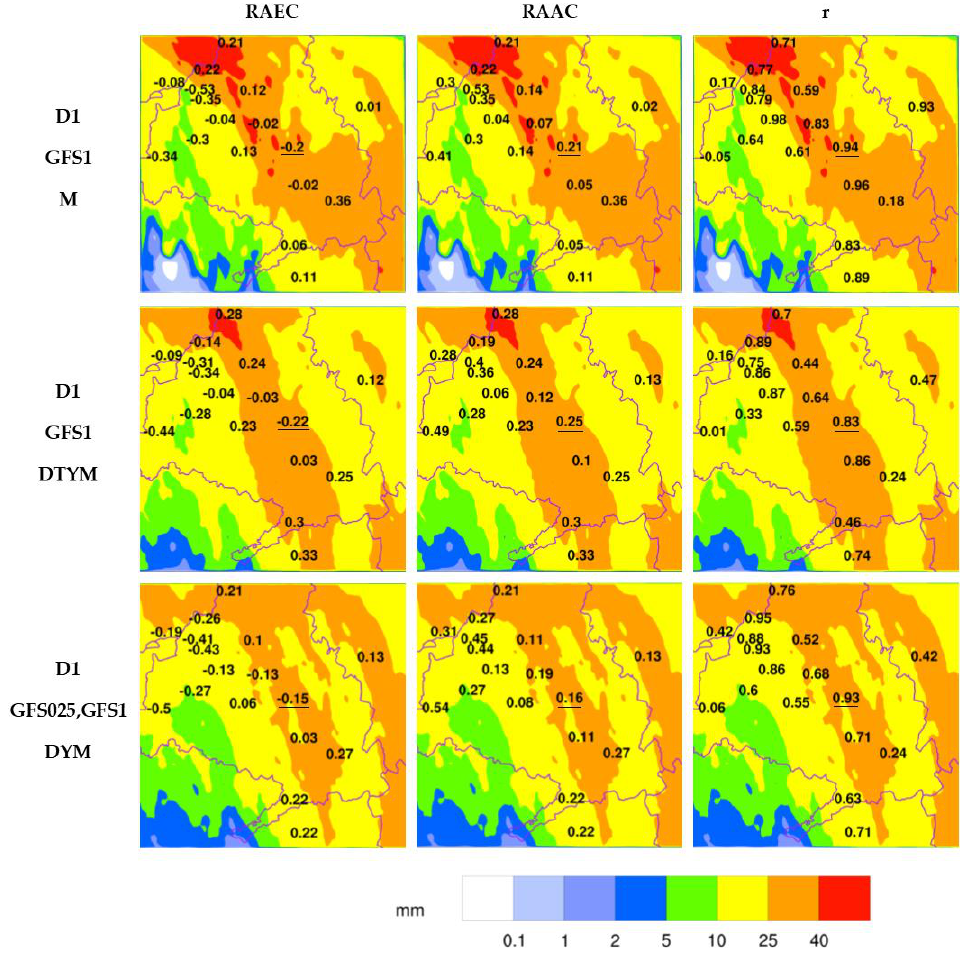
Figure 4. Accumulated precipitation (mm) between 10:00 and 18:00 UTC for the best performing model configurations. RAAC, RAEC and r values for each station are shown at station locations.